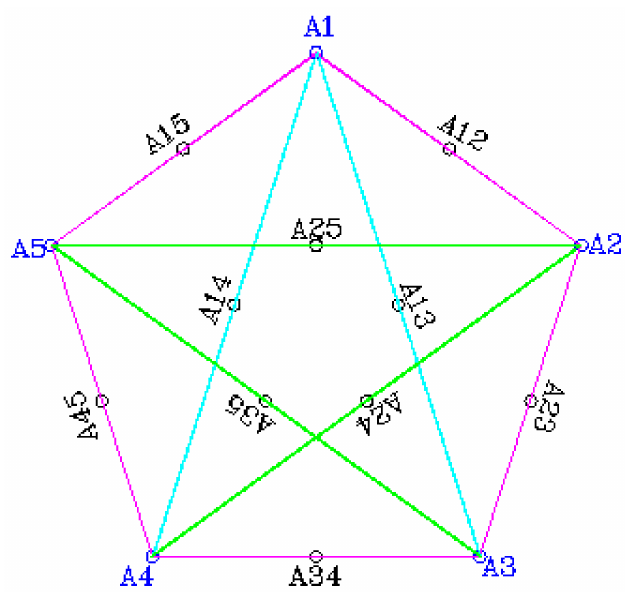
Figure 2. Defined experimental points using Scheffe’s simplex